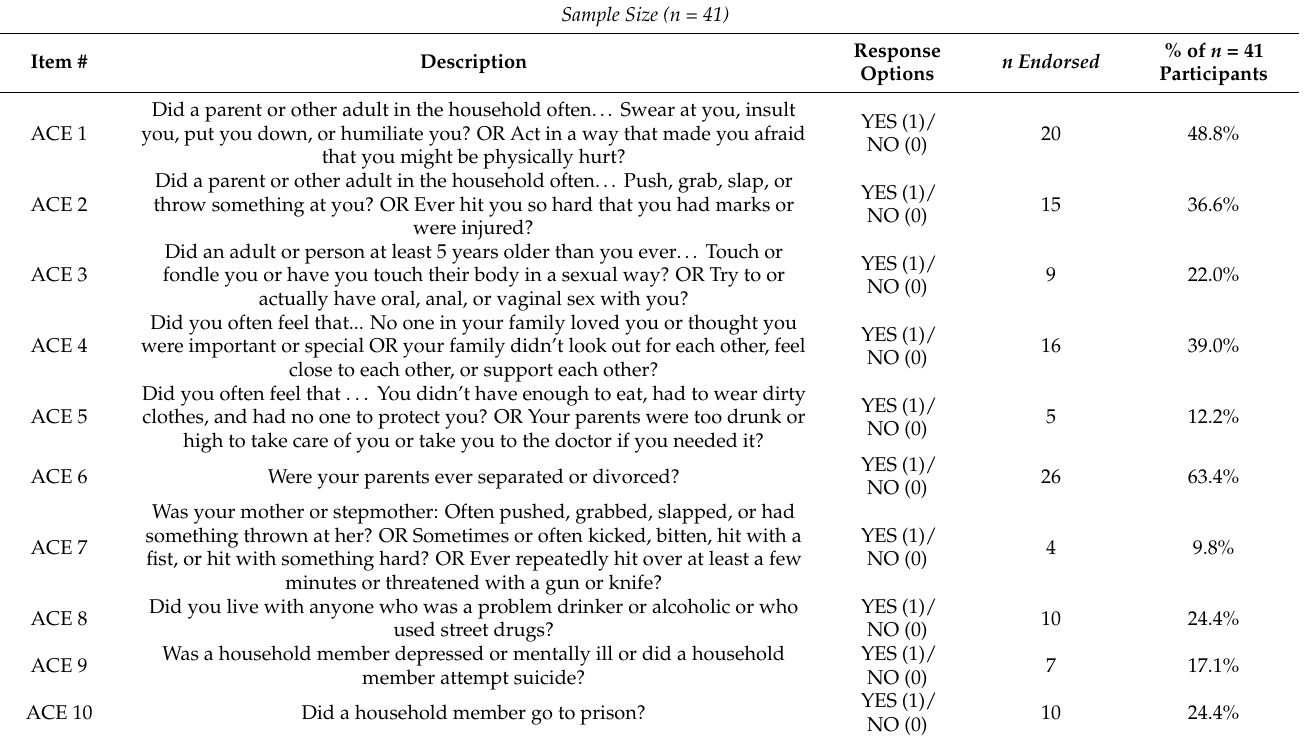
Table 2. Endorsement of individual ACE items. Sample Size (n =